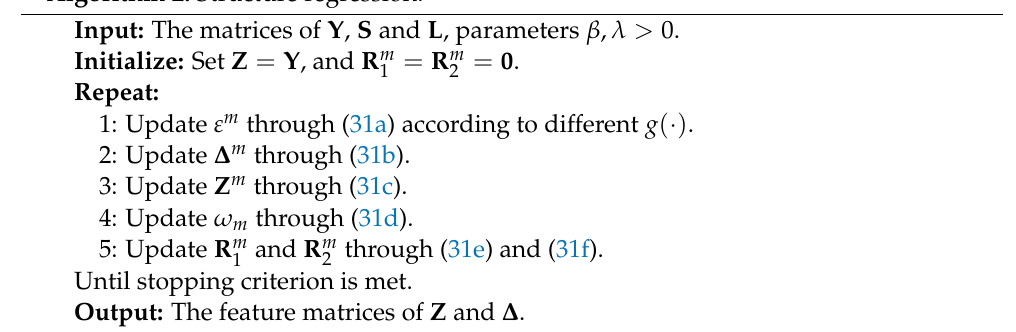
Algorithm 2: Structure